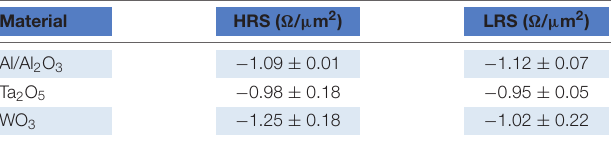
TABLE 2 | Slope of the linear fit of the resistance vs. area plot for all the different materials.